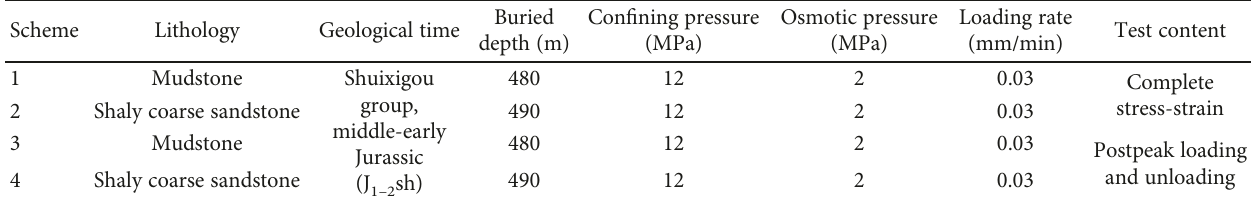
Table 1: Specimen information and testing